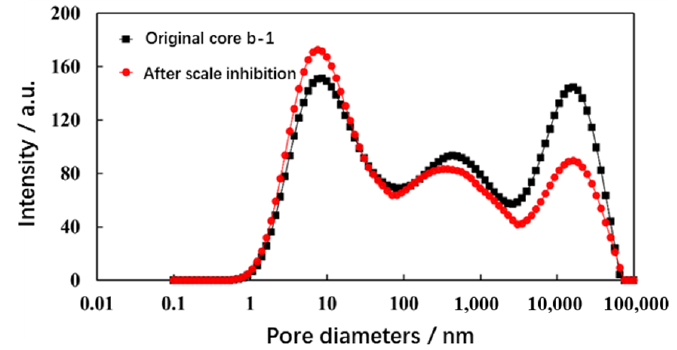
Figure 8. NMR curve of propped core b-1 before and after scaling without scale inhibitor.